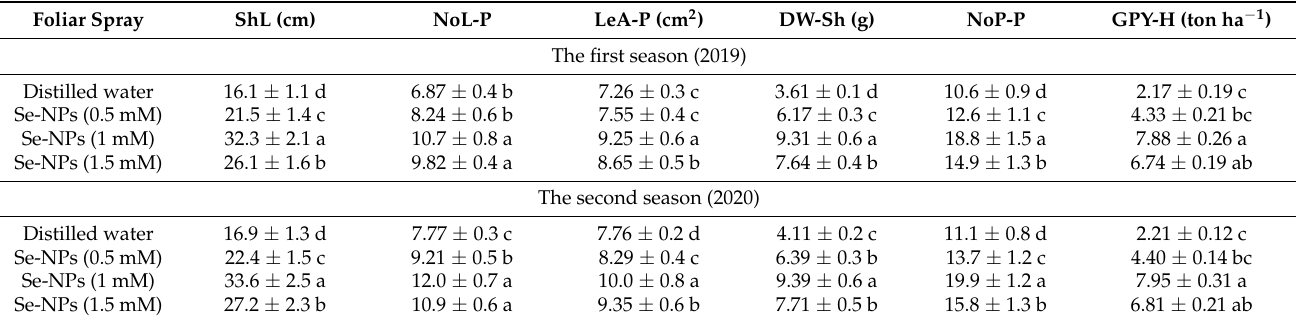
Table 3. Growth and productivity responses of salt-stressed common bean plants (soil EC = 7.55–7.61 dS m − 1 ) to foliar nourishment with selenium dioxide nanoparticles (Se-NPs) in two consecutive